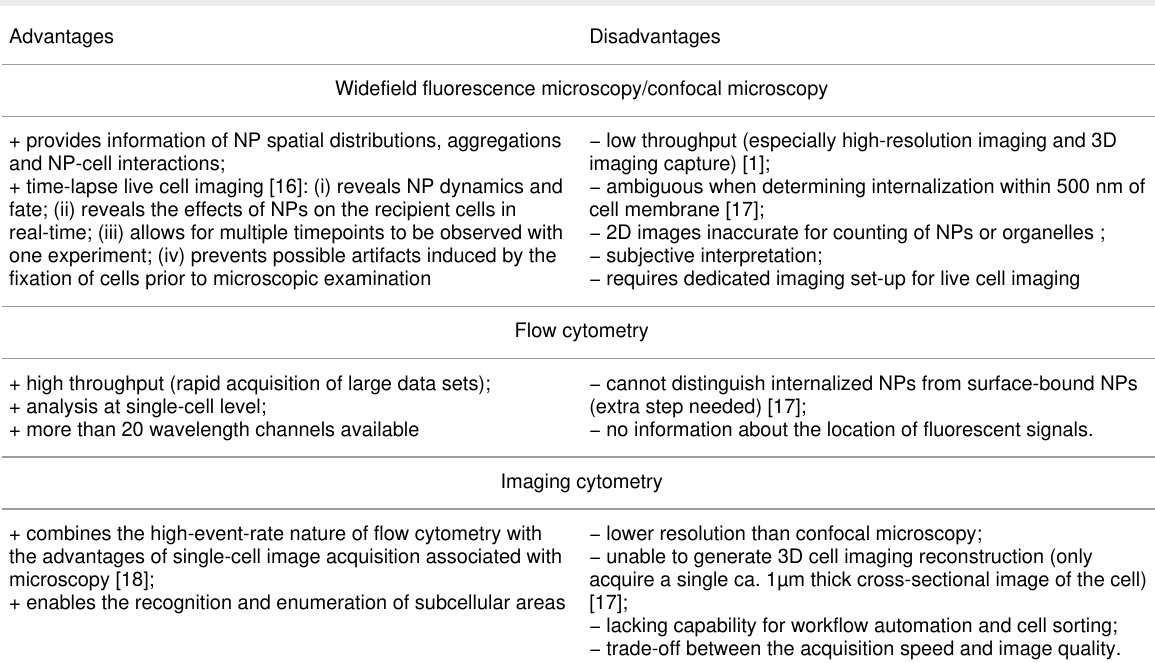
Table 1: Characteristics of techniques used to investigate cellular uptake and transfection of